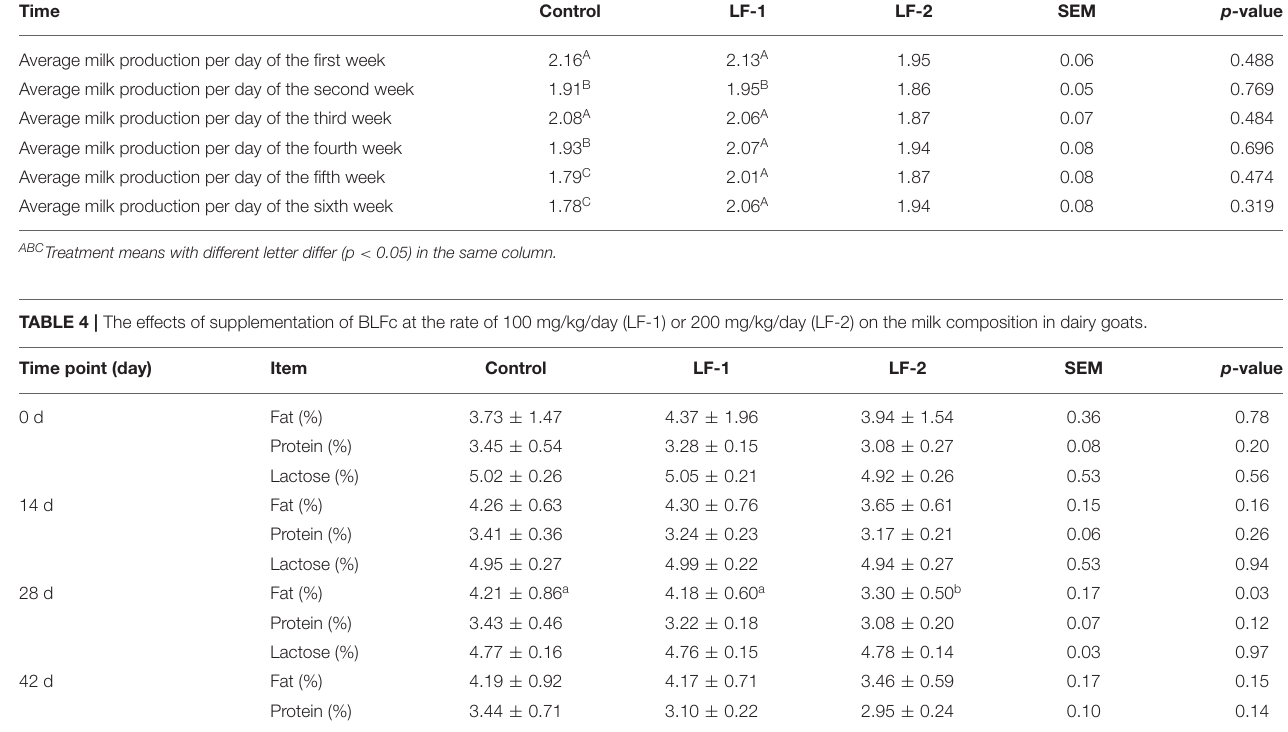
TABLE 3 | The effect of supplementation of BLFc at the rate of 100 mg/kg/day (LF-1) or 200 mg/kg/day (LF-2) on milk production throughout the experiment. Time Control LF-1 LF-2 SEM p- value